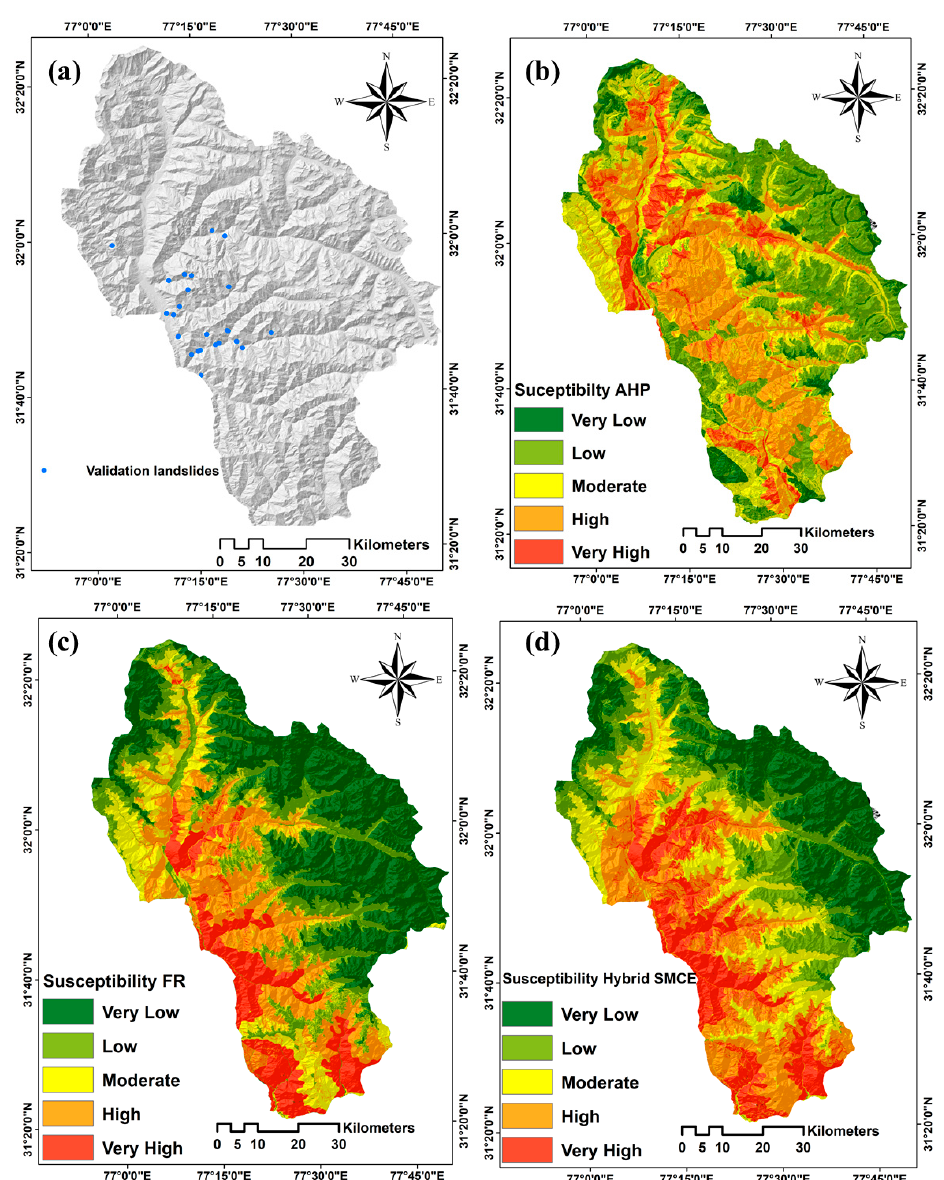
Figure 3. ( a ) Landslide inventory and output landslide susceptibility maps for each method, ( b ) AHP, ( c ) FR, and ( d ) hybrid SMCE. ( c ) FR, and ( d ) hybrid